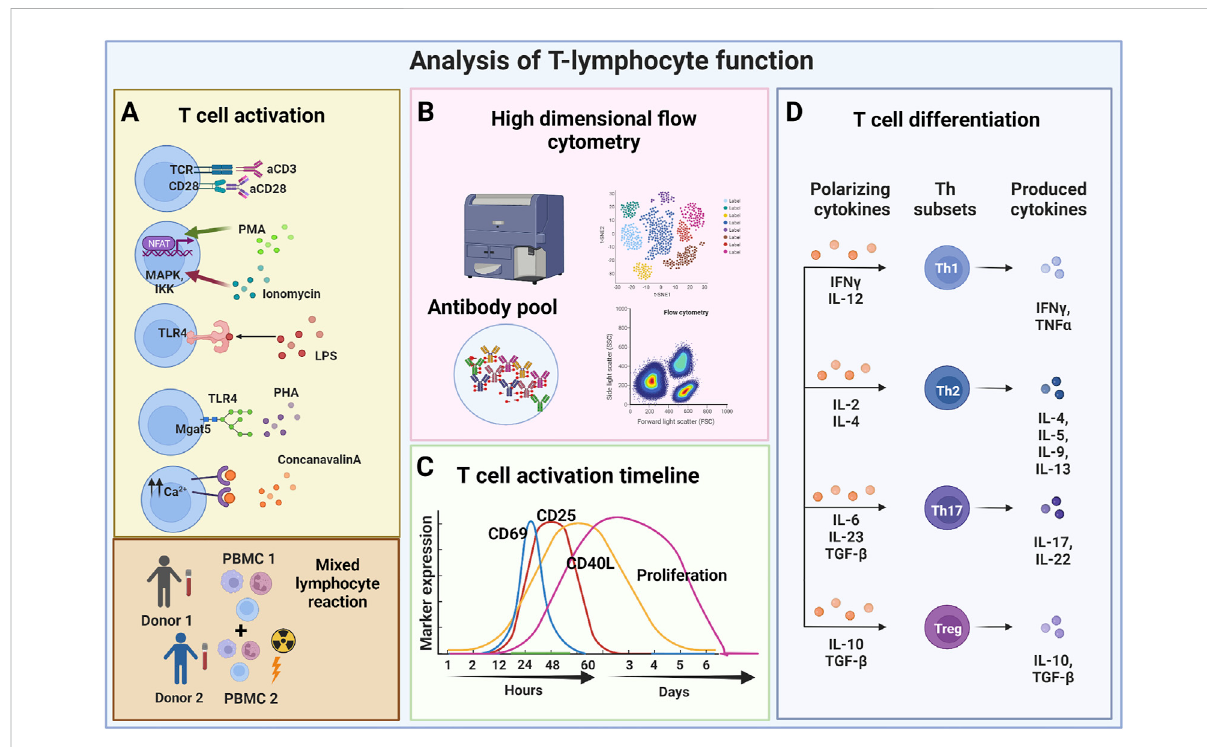
FIGURE 1 Analysis of T-lymphocyte function. (A) T lymphocytes can be activated using various stimuli including monoclonal antibodies (stimulation with anti-CD3 anti-CD28), and mitogens, such as PMA frequently used in combination with ionomycin. Other modes of stimulation include the use of lipopolysaccharidesthattriggersTLR4activation(thusmimickingthebacterialstimulus),andcausingthereleaseofPHAthatinducestherecruitment ofTCRsconsequentlyactivatingTlymphocytes.Finally,TlymphocytescanalsobestimulatedbyConA,whichcausesthereleaseofintracellular Ca 2+ that triggers the calcium cascade, and by mixed lymphocyte reactions which are based on the allogeneic response determined by HLA mismatching between two different donors. (B) Depending on the considered mechanism of action, different readout methods are used. Flow cytometry can perform in-depth immune-phenotype analyses. (C) Variousmarkerscanbeused toanalyze Tcell activityingiven assays, somebeing selectively expressed at speci fi c timepoints following T cell activation. (D) The functional polarization of T lymphocytes can be triggered